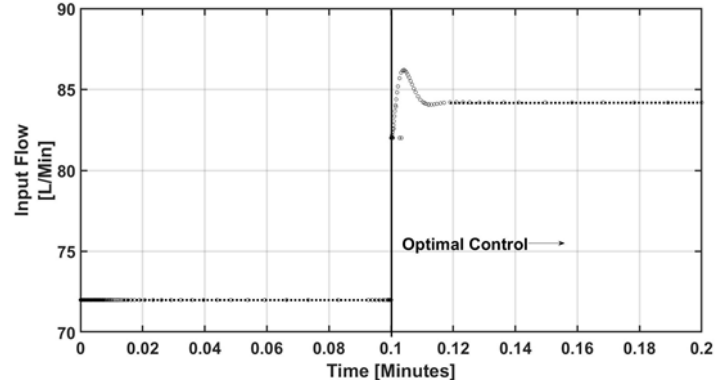
Figure 5. Control effort of the optimal controller.